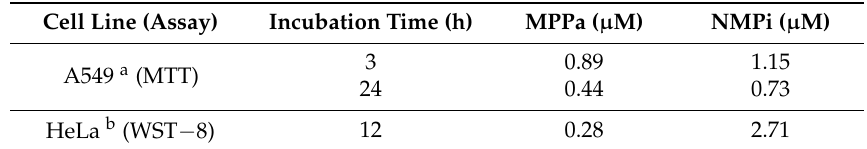
Table 1. IC 50 values of MPPa and NMPi against A549 a and HeLa b cells at 3 h and 24 h, and 12 h incubation times after irradiation (total light dose 2 J/cm 2 for 15 min), respectively.